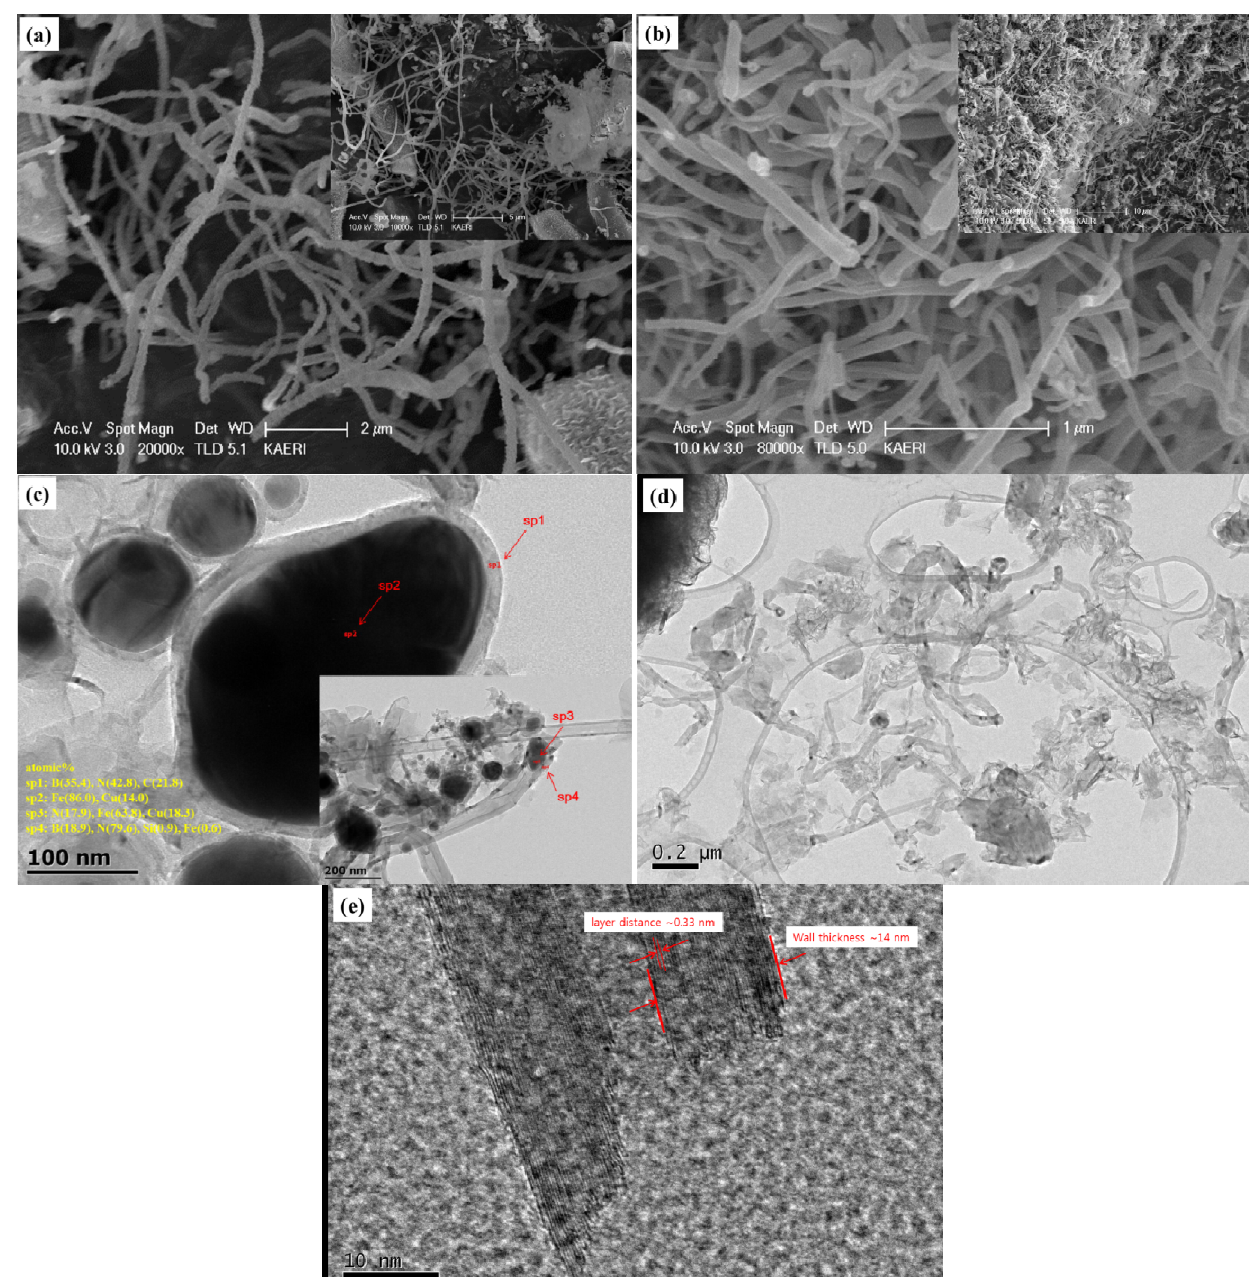
Figure 6. SEM images of BNNTs samples synthesized from the: ( a ) crystalline boron precursor; and ( b ) amorphous boron precursor. TEM images of BNNTs samples synthesized from the: ( c ) crystalline boron precursor; and ( d , e ) amorphous boron precursor with a nozzle-type